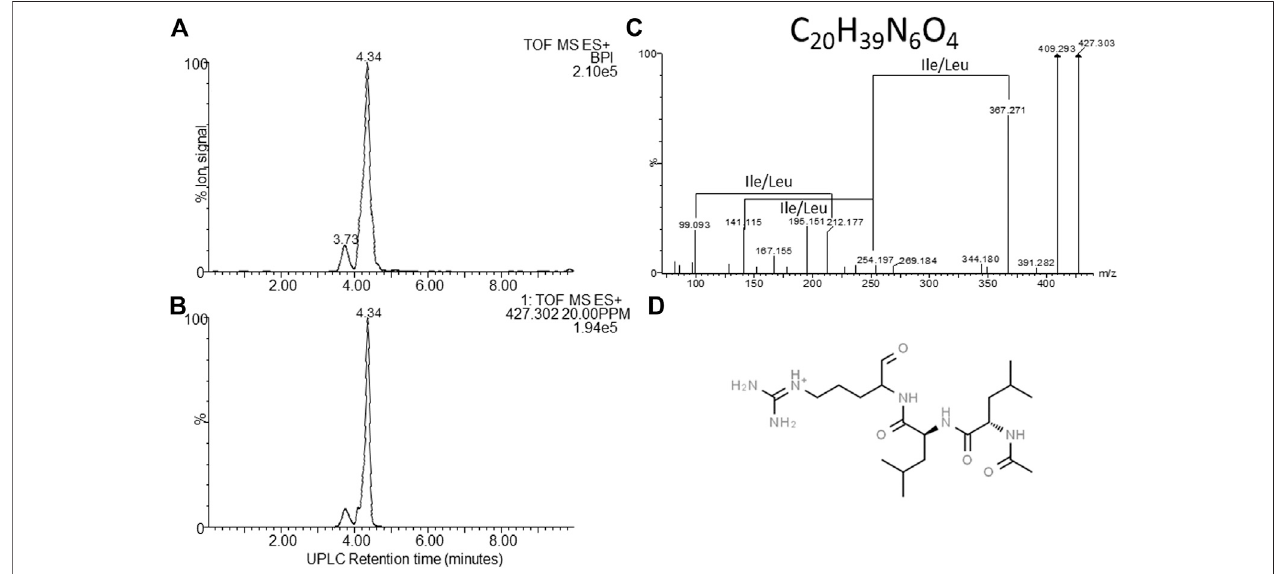
FIGURE7 | Structural analysesof compound 8 – khoicin. (A) UPLC-MS analysis ofthe puri fi ed compound and (B) the extracted m/z chromatogram ofthe khoicin ion with m/z (cid:1) 427.302, (C) high resolution MS-MS spectrum of 427.302; (D) proposed working structure for khoicin.